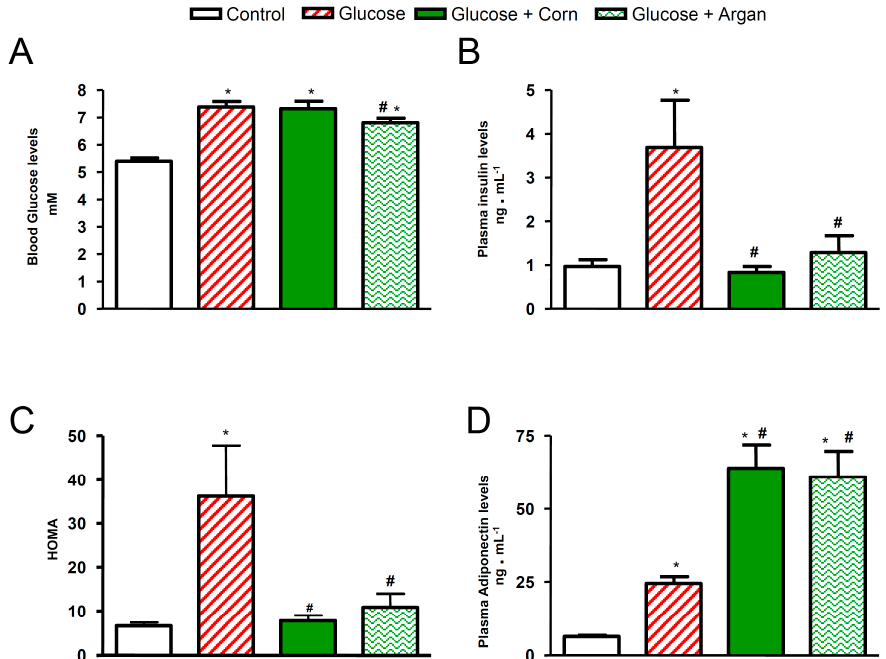
Figure 2. Effects of 12 weeks of glucose feeding combined or not with orally and daily administered (5 mL·kg − 1 ) corn oil or argan oil on ( A ) blood glucose levels expressed in mM, ( B ) plasma insulin levels expressed in ng·mL − 1 , ( C ) HOMA (plasma glucose × insulin/22.5) and ( D ) plasma adiponectin levels expressed in ng·mL − 1 . Values are the mean ± SEM of 7–10 rats per group. * p < 0.05 vs. control, # p < 0.05 vs. glucose.